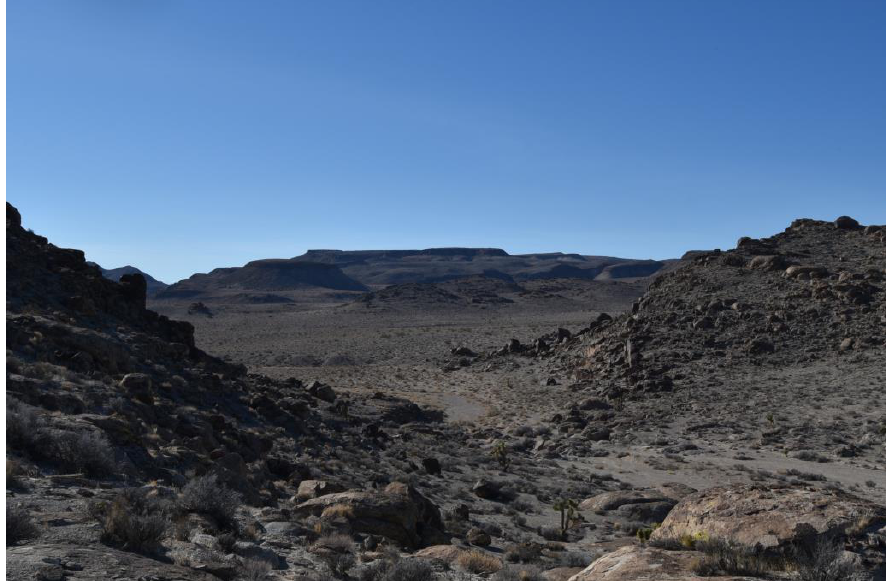
Figure 14. Gap at Eagle Head with trail in center (Source: Stoffle).